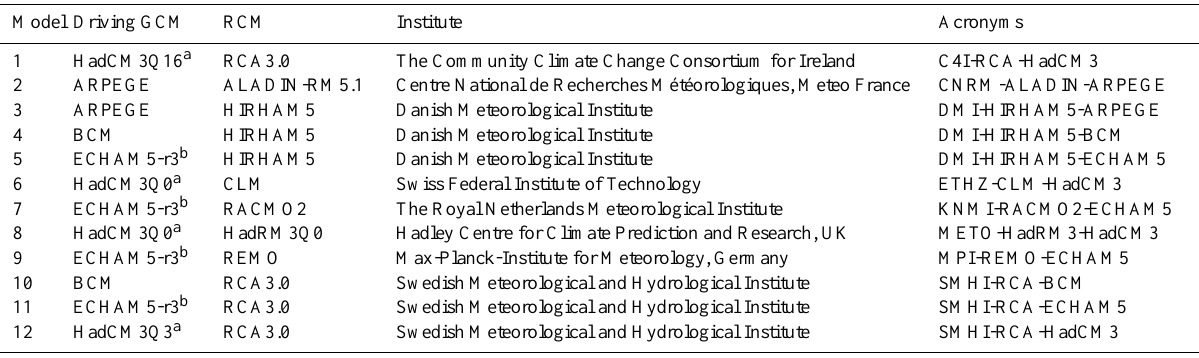
a Represent three versions of the HadCM3 model with perturbed parameterization impacting the simulated climate response sensitivities: Q0 (reference), Q3 (low-sensitivity) and Q16 (high-sensitivity) (Collins et al., 2006). b Represent one run of the ECHAM5 model using three different sets of initial conditions defined as “-r1”, “-r2”, and “-r3” (Kendon et al.,